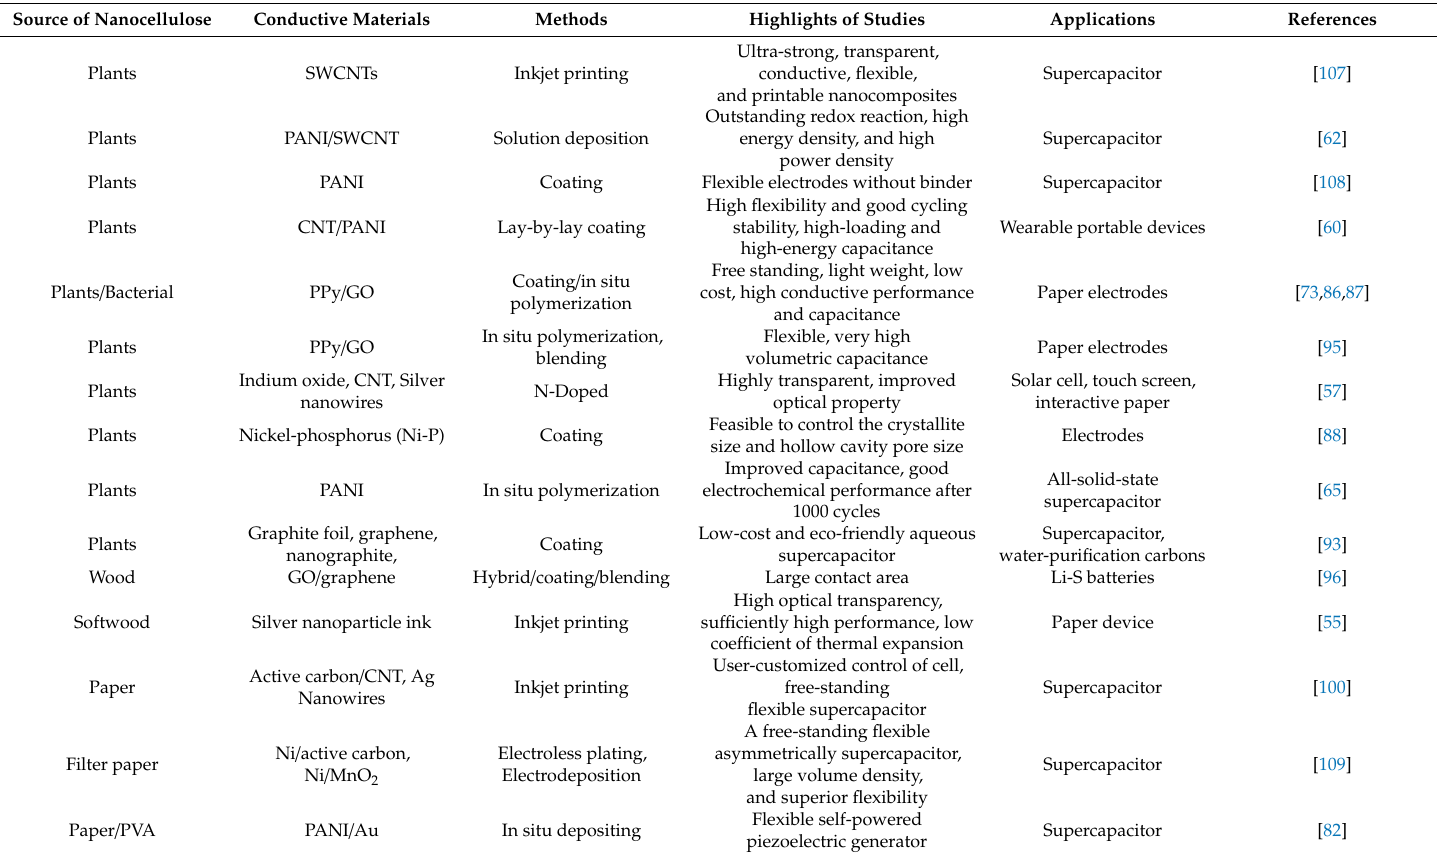
Table 2. Summary of nanocellulose-based conductive membranes developed for supercapacitors and energy storage